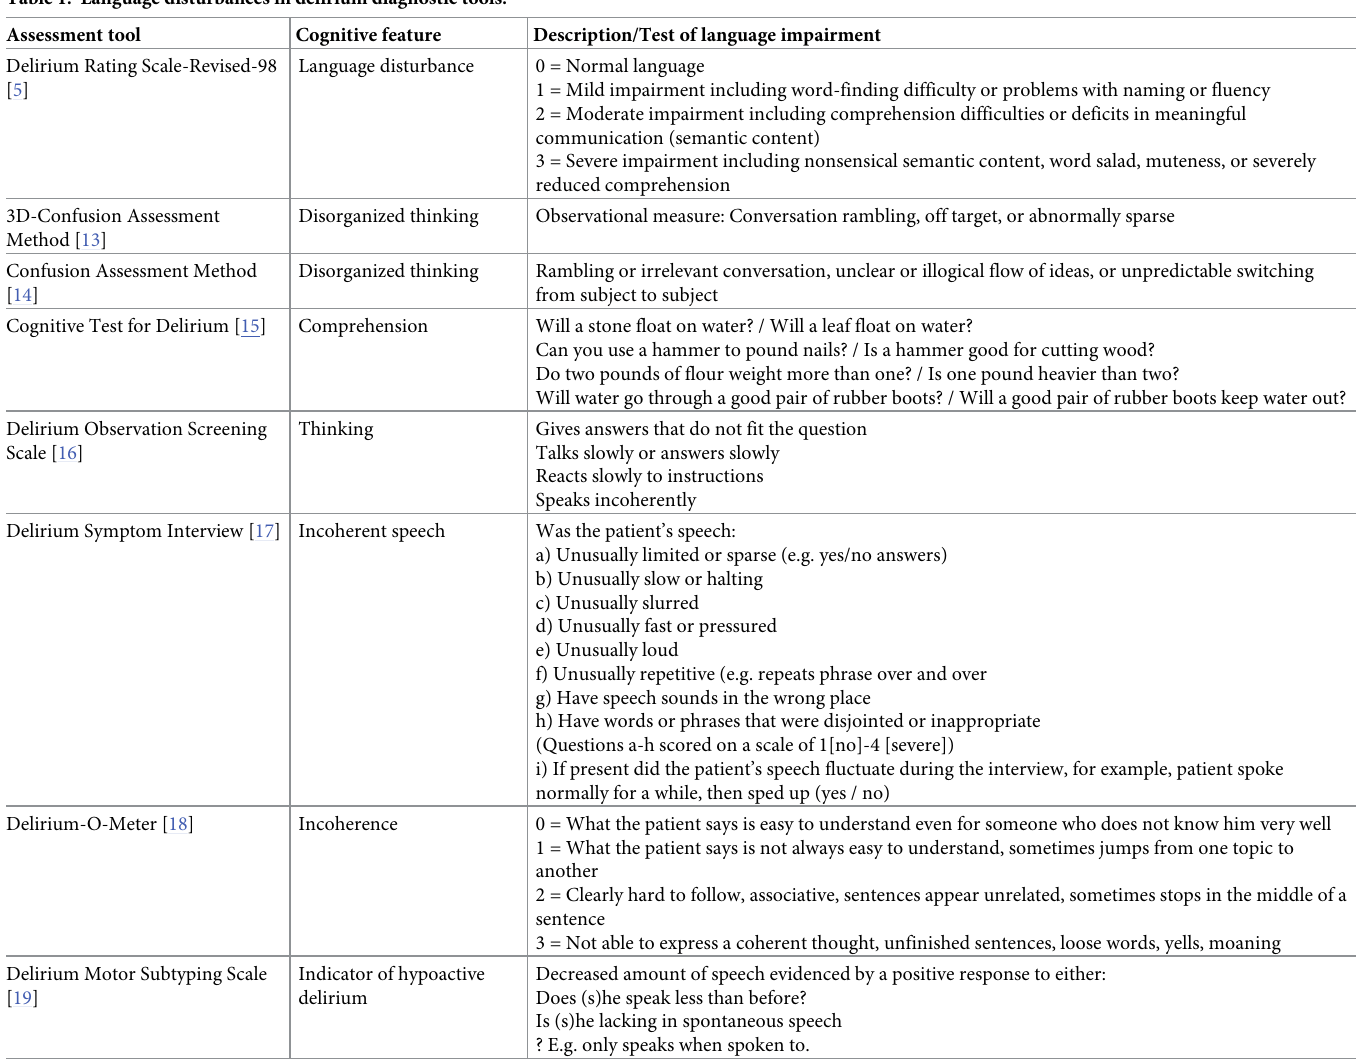
Table 1. Language disturbances in delirium diagnostic